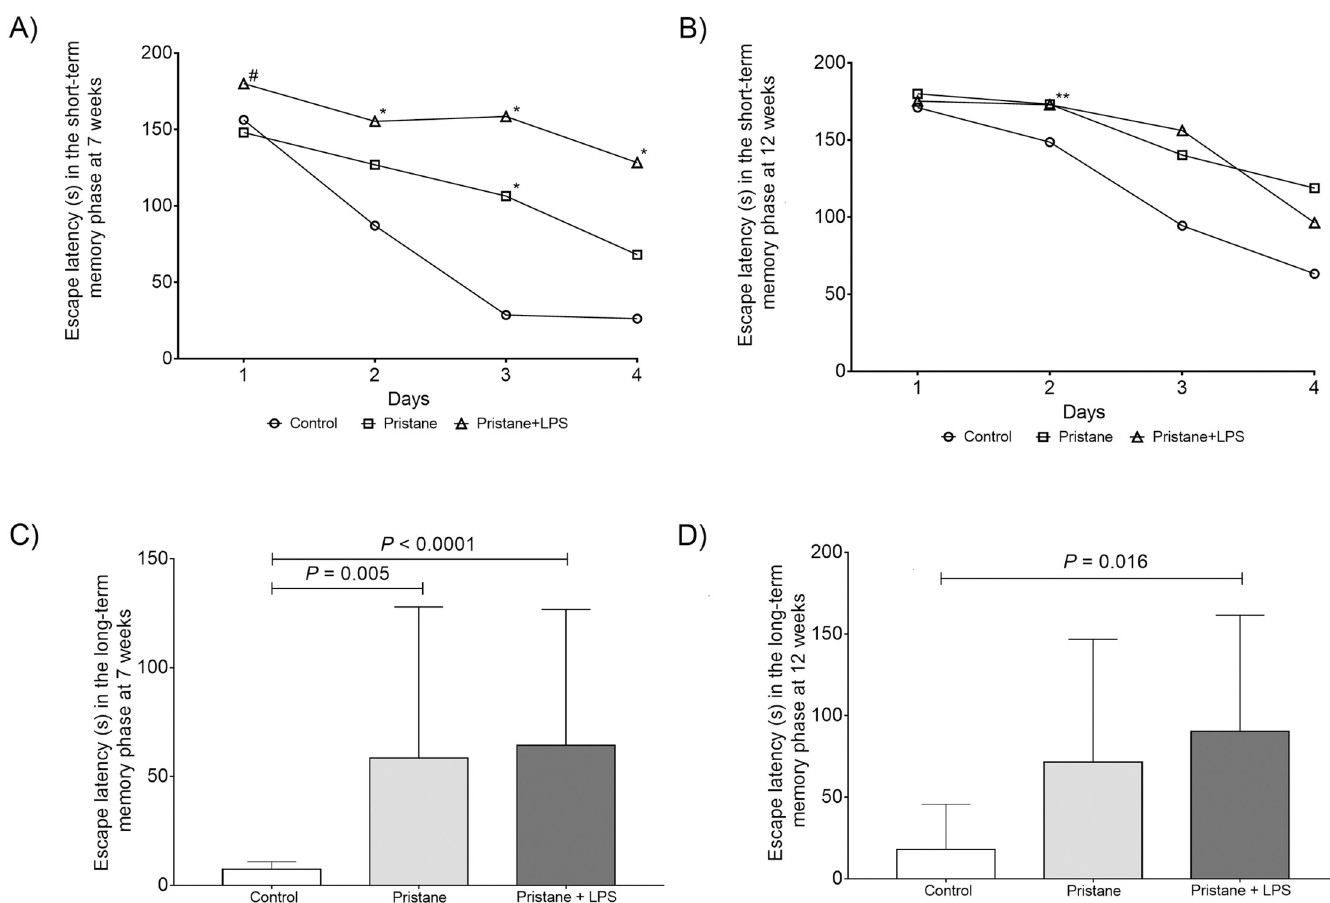
Fig 2. Escape latency of experimental subgroups in STM and LTM. Data are shown in � x ± SE. #differences between pristane and pristane+LPS groups, � differences between control and pristane or pristane+LPS. Unpaired Mann Whitney U test, P < 0.05. A) Escape latency in the STM phase at 7 weeks. B) Escape latency in the STM memory phase at 12 weeks. C) Escape latency in the LTM phase at 7 weeks. D) Escape latency in the LTM phase at 12 weeks.